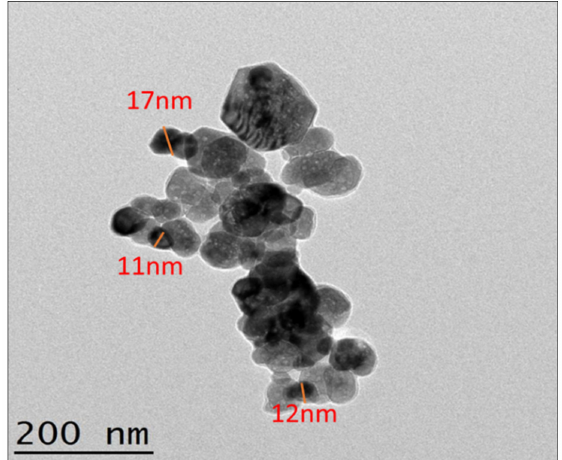
Figure 8. ZnO nanoparticles size and morphology confirmation using